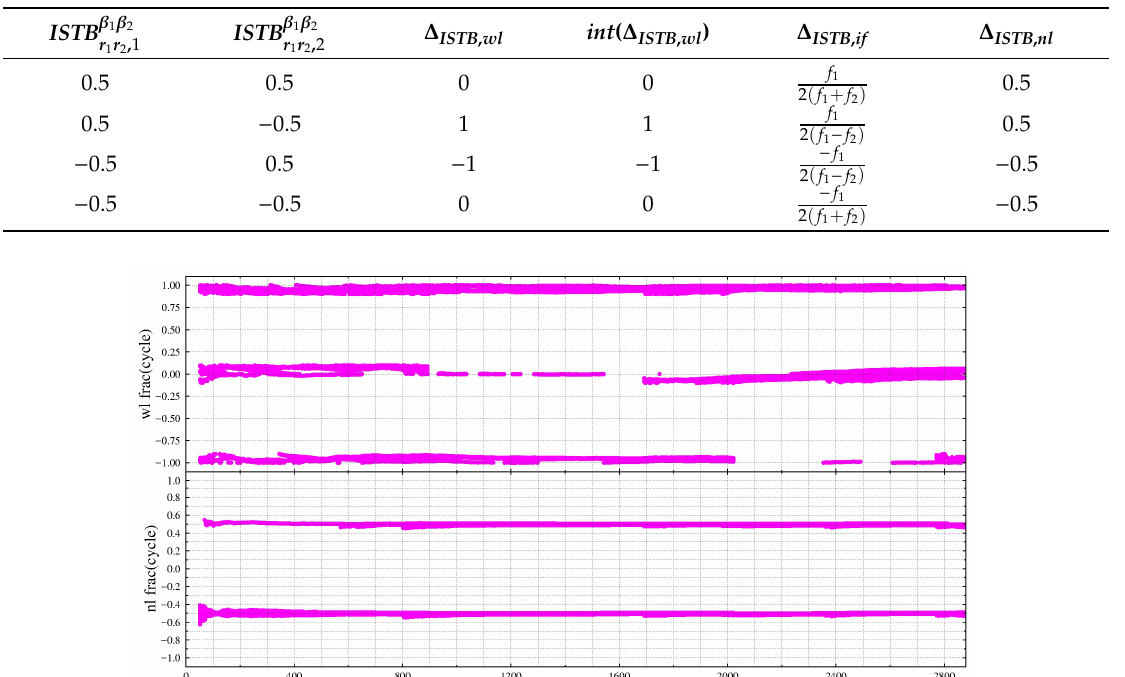
Figure 2. The fractional parts of WL and NL DD ambiguities for GEO and non-GEO Satellites at zero- baseline CUCC-CUTC.